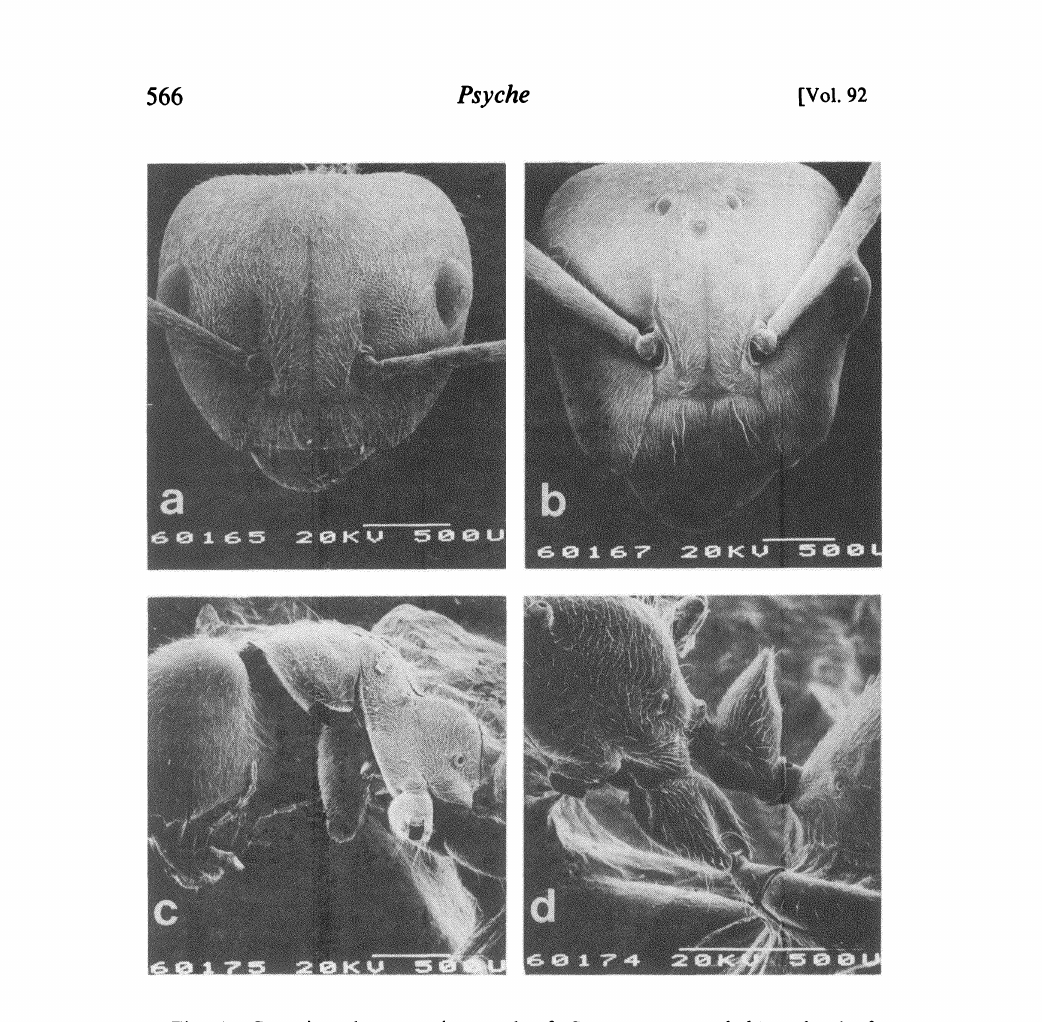
Fig. 4. Scanning electron micrograph of Camponotus gombaki; a, head of worker; b, head of female; c, alitrunk of worker in profile; d, petiole of worker, with parts of alitrunk and gaster in